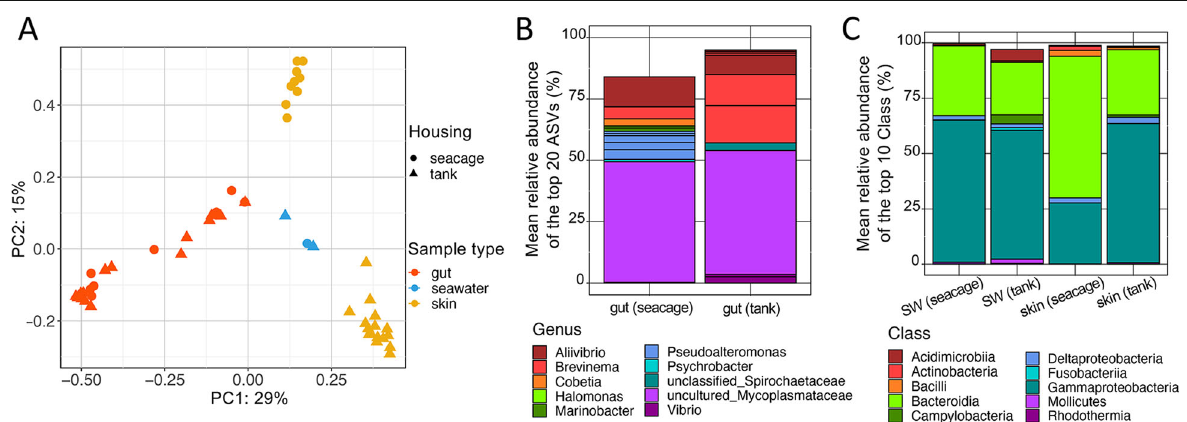
Fig. 2 Impact of acclimatisation on the gut and skin microbiota of yellowtail kingfish. a PCoA plot representing Bray-Curtis similarities comparing global bacterial assemblages between sample types (gut, skin and seawater) from fish housed in seacages and those relocated and acclimatised in tanks. b - c Stacked barplots presenting the mean relative abundance (%) of the top 20 most abundant bacterial ASVs found in the gut of fish and the top 10 bacterial Classes found in the seawater (SW) and on the skin of fish, respectively, comparing fish housed in seacages and those relocated and acclimatised in